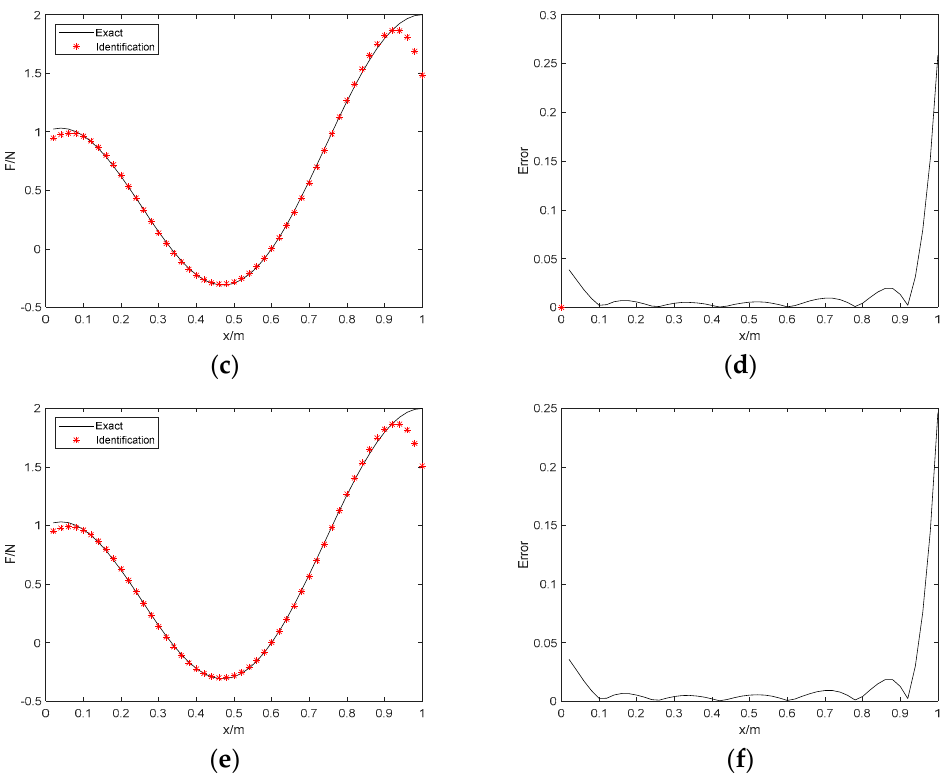
Figure 3. The identification results with 1% noise. ( a ) Proposed method; ( b ) identification error; ( c ) Tikhonov with L − curve regularization; ( d ) identification error; ( e ) Tikhonov with GCV regulariza- tion; ( f ) identification error. Table 2. Identification error in Example 1.